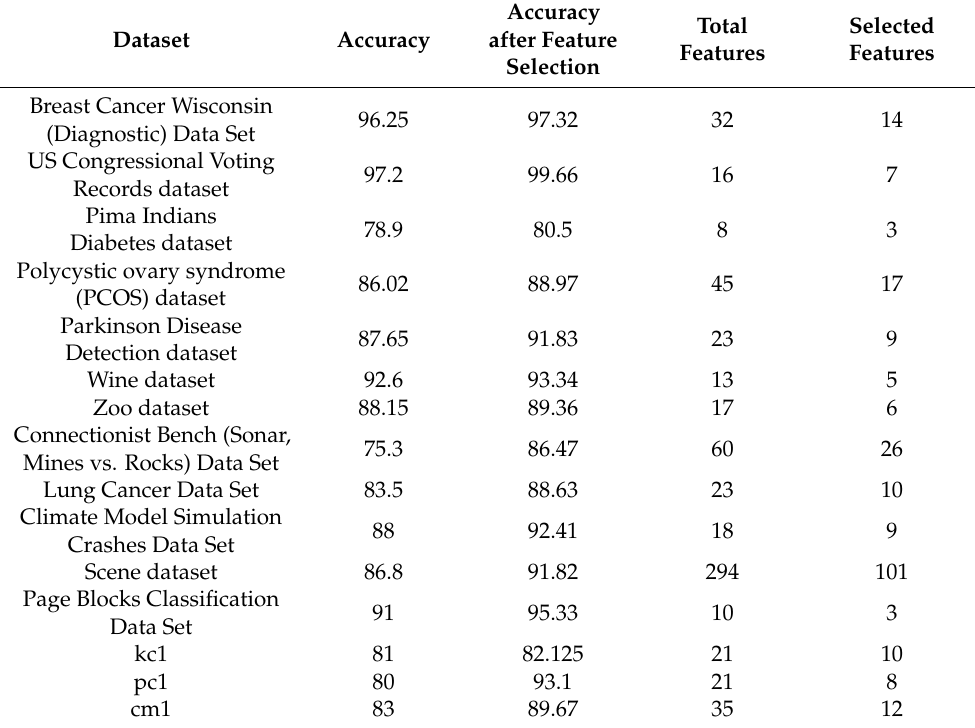
Table 4. Results obtained from proposed FCM-based feature selection